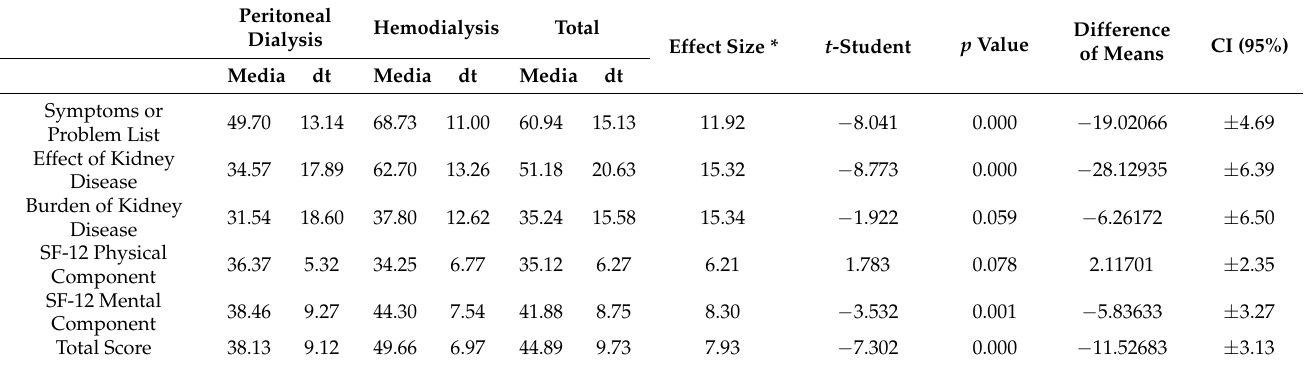
Table 4. Quality of life according to renal replacement therapy using the Mann-Whitney U Test.